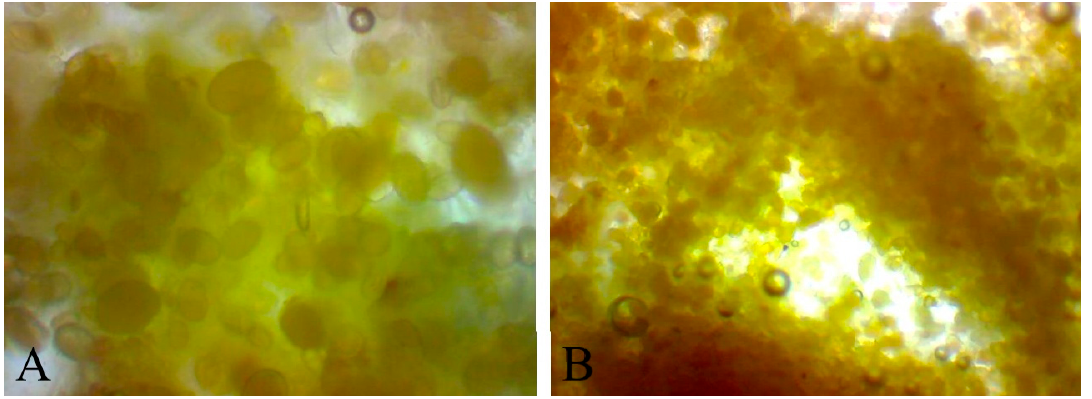
Figure 5. An effect of storage time on the content of phenolic compounds in beebread caviar; p a-b = 0.00345; p b-c = 0.04104 .